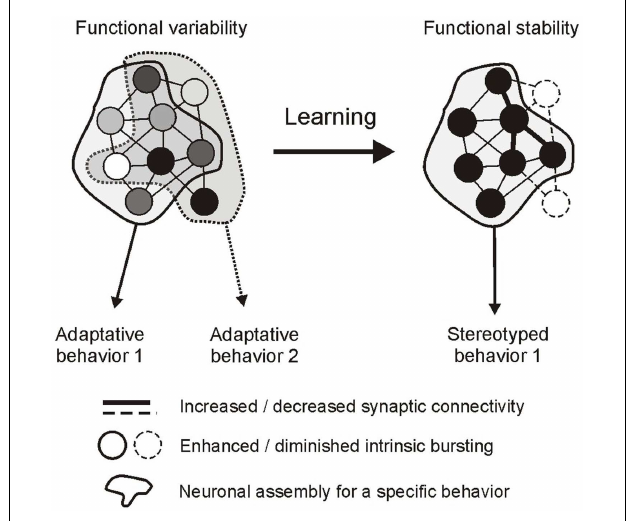
FIGURE 7 | Hypothetical representation of a decision-making network and its regulation by operant learning in Aplysia . Left, the global circuit is composed of a pool of neurons (circles) that generate erratic and weakly coordinated impulse bursts (indicated by different shading intensities) as a result of specific intrinsic properties and pattern of connectivity.The network can generate different adaptive behaviors depending on the participation of individual neurons. Some cells contribute to common features of the different behaviors (neurons in the overlapping area), others contribute selectively to a single behavior (neurons in the non-overlapping areas). Behavioral occasion setting is at least in part governed by the variability in burst coordination in the former subset of neurons, while behavioral selection depends on burst recruitment/exclusion in the latter subset. Right, learning rigidifies network functioning by modifying synaptic connectivity and intrinsic bursting properties. As a result, coordinated bursting now reduces the variability in occasion setting and pattern selection, allowing the expression of a single stereotyped rhythmic